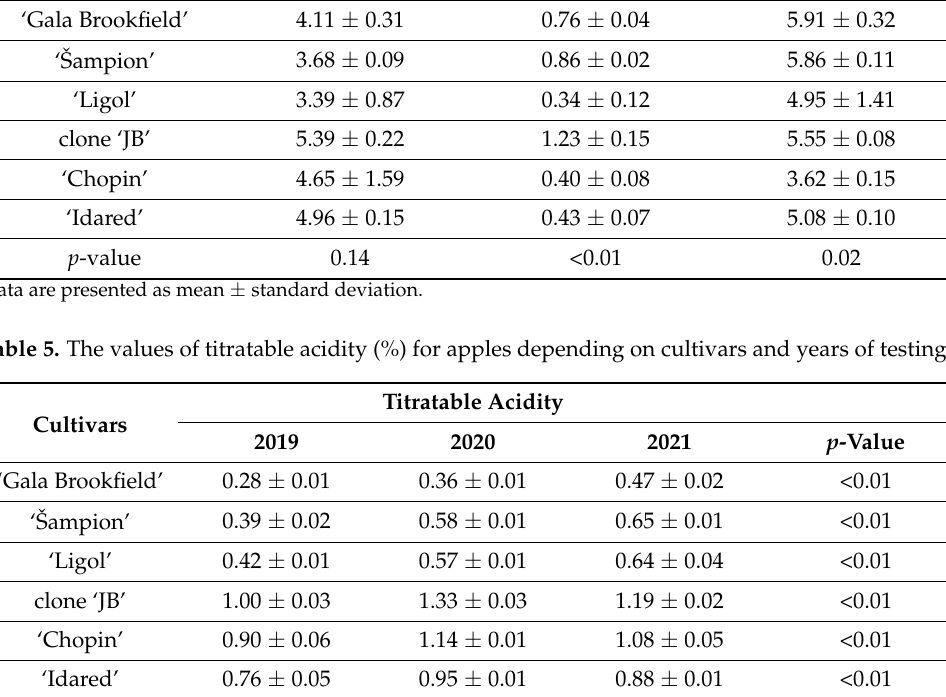
Table 4. The values of sugar content (g · 100 g − 1 FW) for apples depending on testing cultivars. Cultivars